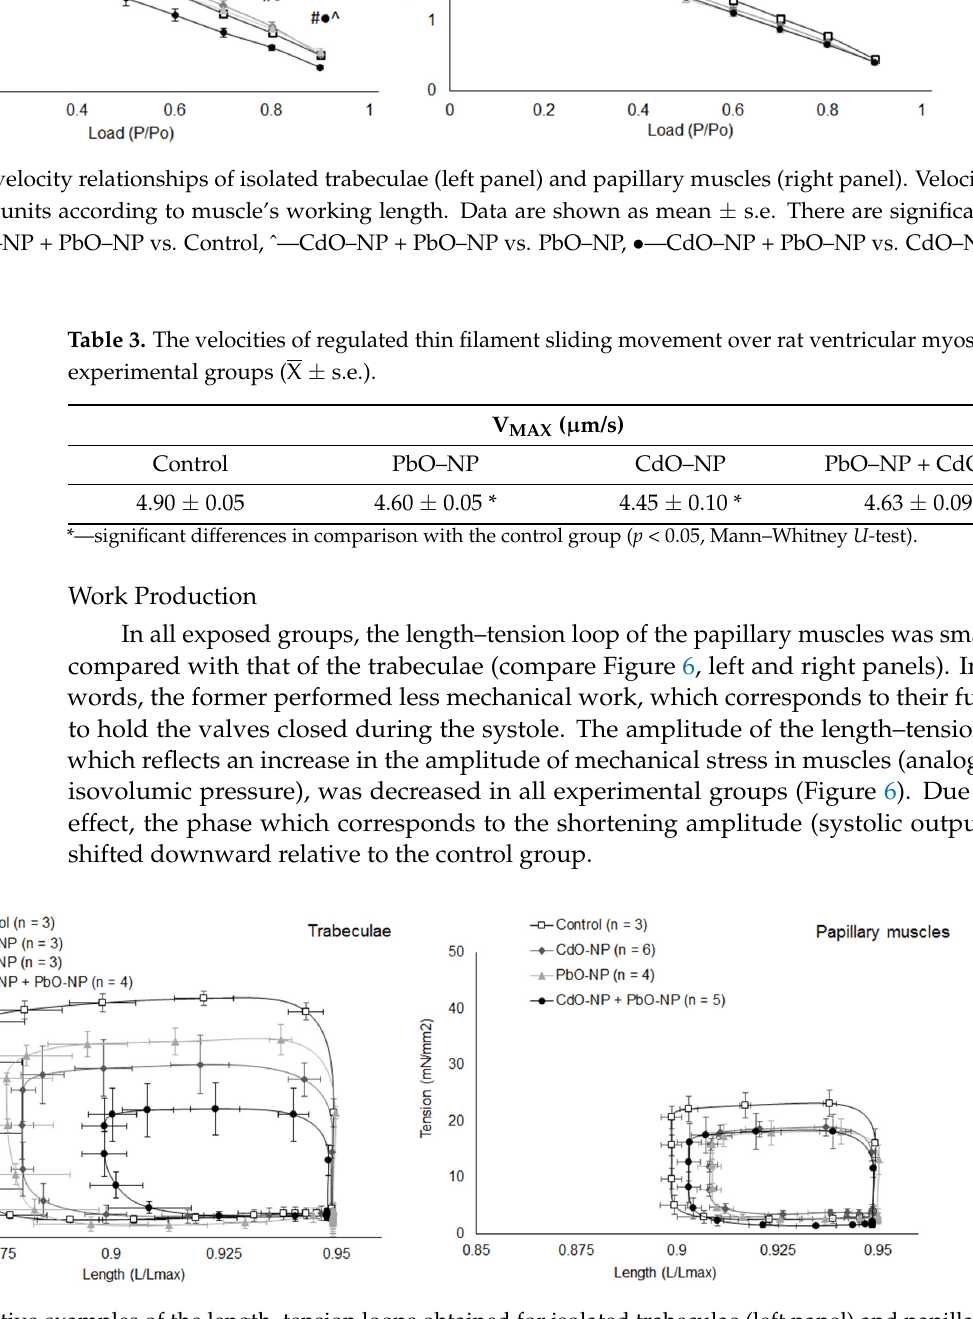
Figure 7. The end–systolic length–afterload relationships of isolated trabeculae (left panel) and papillary muscles (right panel). Data are shown as mean ± s.e. There are significant differences: #—CdO–NP + PbO–NP vs. Control, ^—CdO–NP + PbO–NP vs. PbO–NP NP ( p < 0.05, Mann–Whitney U- test). The relationship between the amounts of mechanical work performed by trabeculae and papillary muscles while contracting against different afterloads was found to be extremal in shape (Figure 8). Note that papillary muscles produced ~2.5 times less mechanical work than trabeculae. In all NP-exposed groups of rats, the amount of work performed by cardiac muscles was found to be decreased. This decrease was statistically significant in trabeculae under CdO–NP and CdO–NP + PbO–NP intoxications, while in papillary muscles, under CdO–NP and PbO–NP exposures.